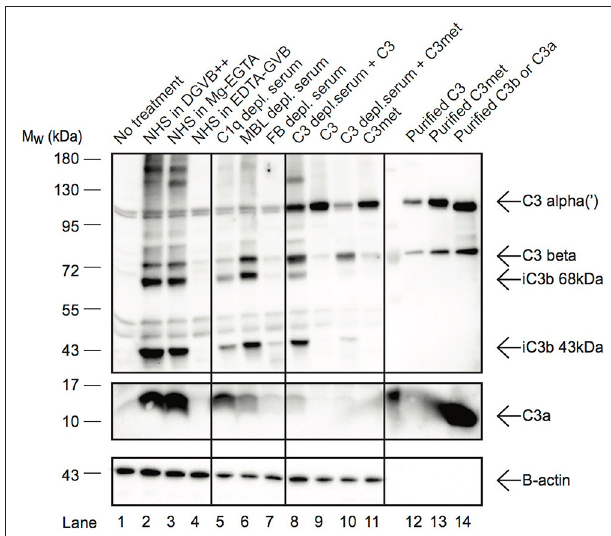
FIGURE 3 | C3a in B cells is generated extracellularly by alternative pathway C3-convertases. Western blot results investigating the origin of C3a in Raji B cells. Cells were incubated with distinct sources of C3 (10% NHS, 100 µ g/ml C3, 100 µ g/ml C3met) in DGVB ++ , Mg-EGTA, or EDTA-GVB buffer for 1h at 37 ◦ C. To analyze complement pathway dependent generation of C3a, sera depleted in C1q (classical pathway), MBL (lectin pathway) or Factor B (alternative pathway) were used. To distinguish intracellular or C3-convertase dependent processing of C3, C3, and C3met were added alone (intracellular cleavage) or in the presence of C3-depleted serum (C3 convertase supplementation). C3 processing and C3a generation were analyzed by Western blot with the goat polyclonal anti-C3 (Quidel) and rabbit anti-C3a (Complement Technologies) antibodies under reducing conditions. Result shown is one representative out of three independent